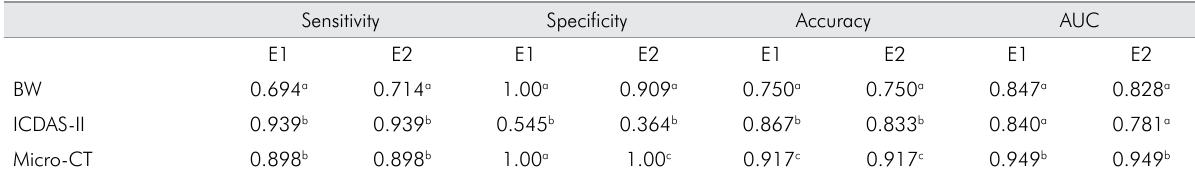
Table 2. Sensitivities, specificities, accuracies, and AUC values for each detection method at threshold D1.